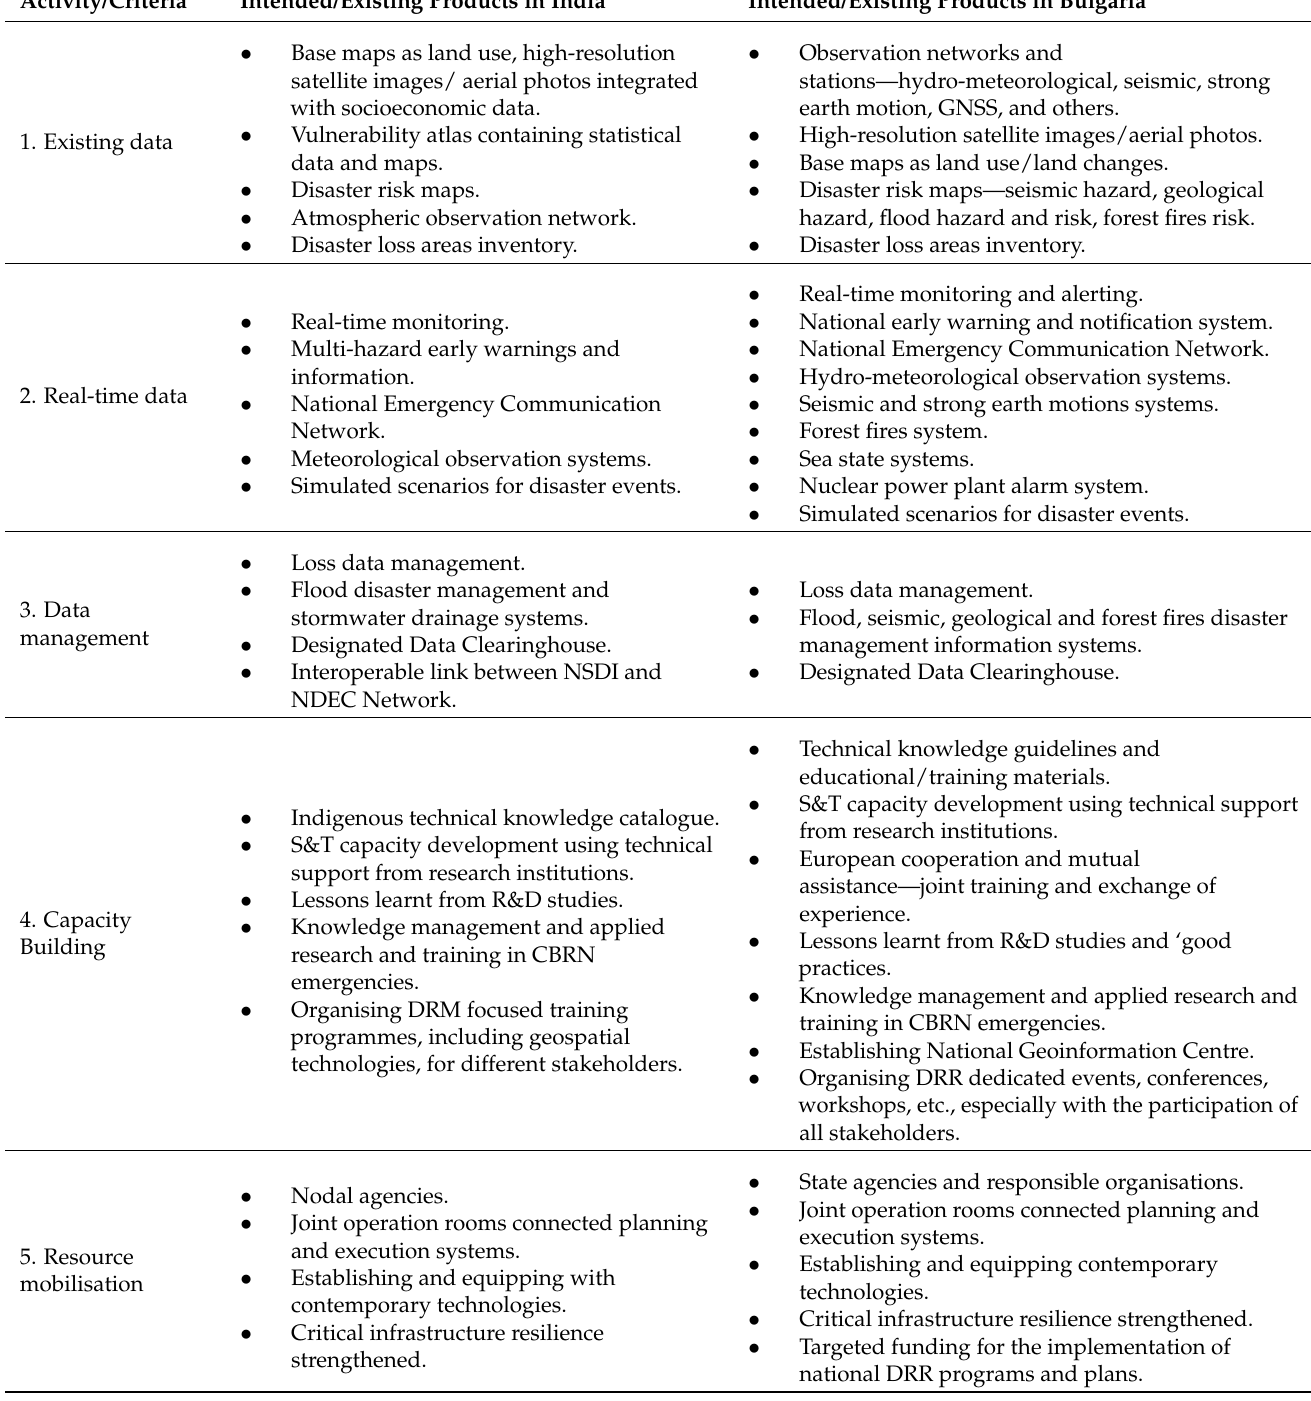
Table 4. Comparative geospatial data/information content between the DRM related policy and plans of India and Bulgaria.